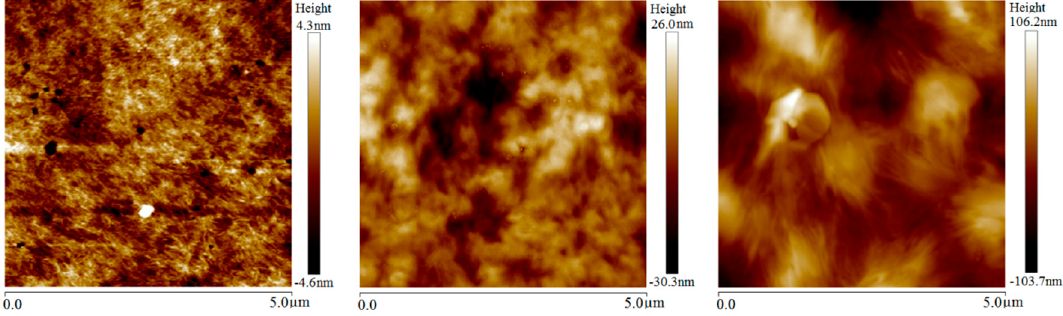
Figure 3. Atomic force microscopy (AFM) images of LDPE without magnetization (left panel) and magnetized at room (middle panel) and elevated (right panel) temperatures.